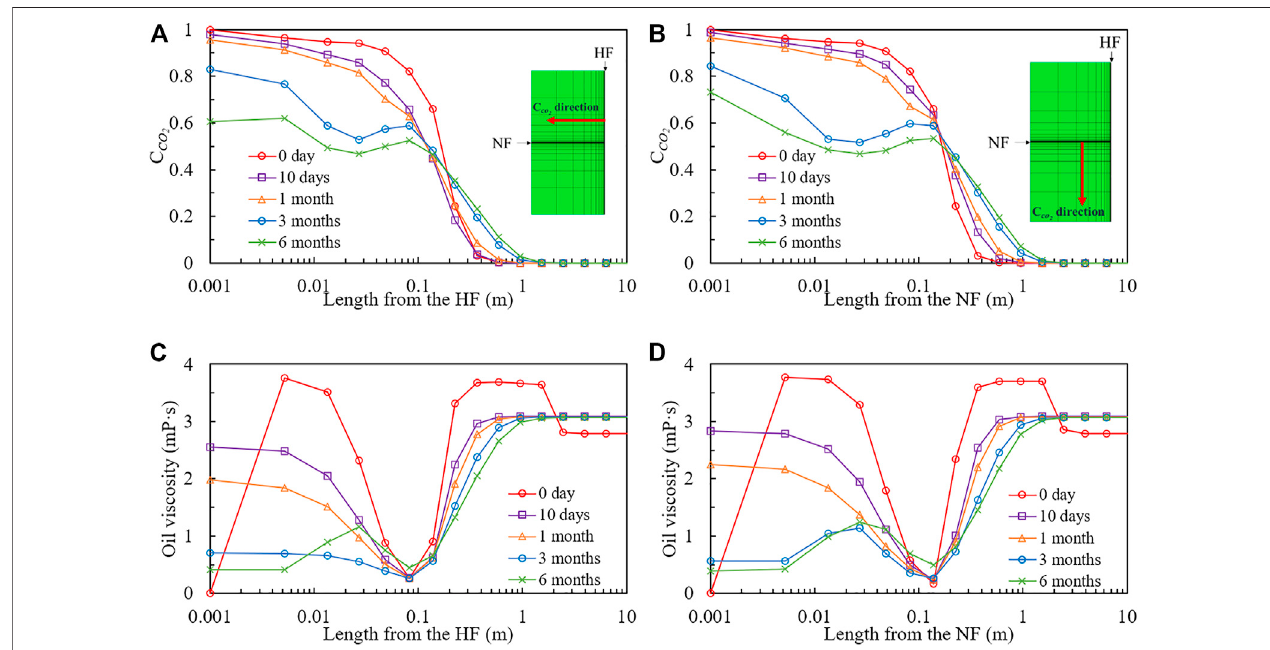
FIGURE 6 | Mole concentration distribution of CO 2 in from HF (A) and NF (B) and viscosity distribution of oil in from HF (C) and NF (D) .